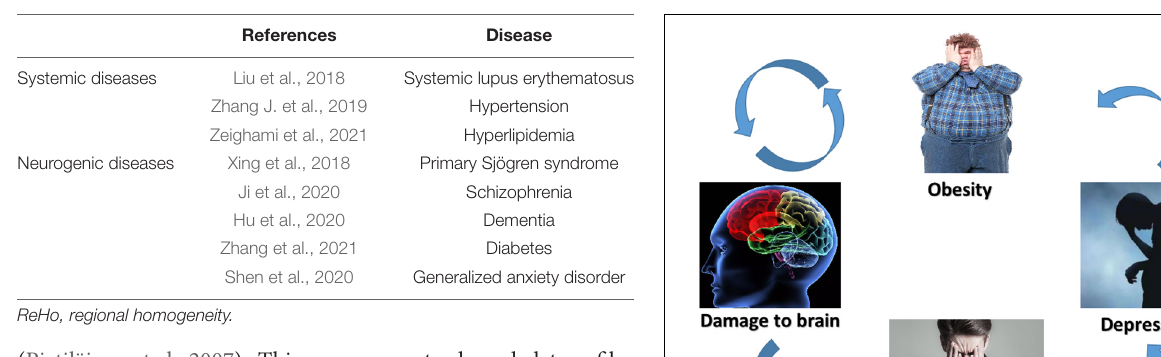
TABLE 3 | Regional homogeneity method applied in systemic and neurogenic diseases.